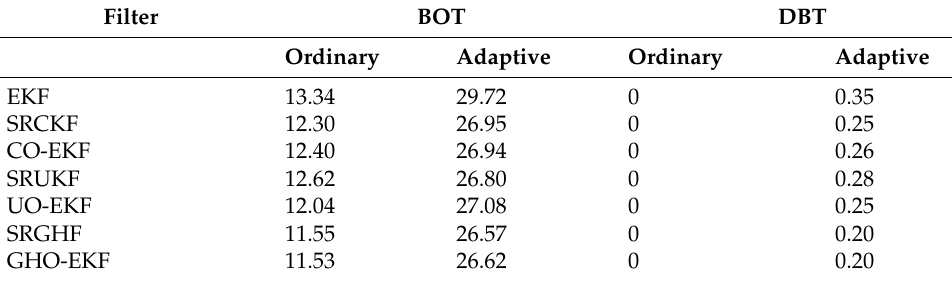
Table 5. Percentage of track loss for BOT and DBT when model mismatch occurs. Filter BOT DBT Ordinary Adaptive